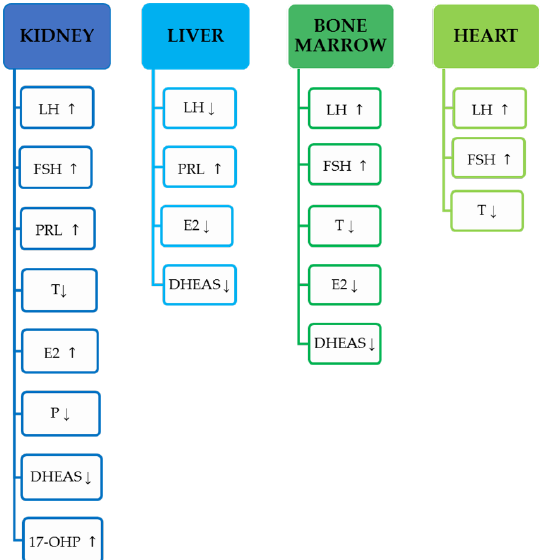
Table 1. Demographical and medical data of renal transplant